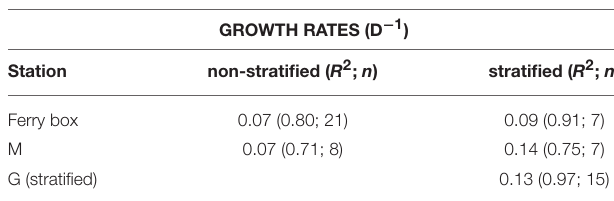
TABLE 1 | Exponential growth rates (d − 1 ) of phytoplankton chlorophyll-a concentration (5 m) of the ferry box data series, and of stations mid fjord (M), and glacier (G), under stratified and non-stratified